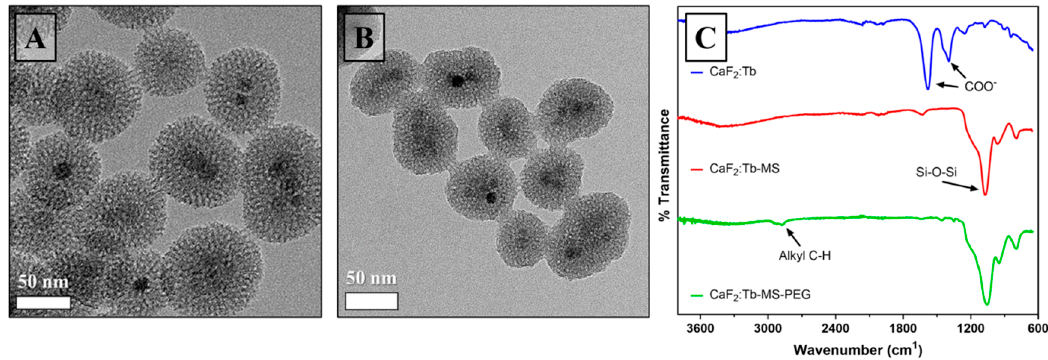
Figure 3. Surface modification of CaF 2 :Tb NPs. TEM images of ( A ) CaF 2 :Tb-MS NPs and ( B ) CaF 2 :Tb-MS-PEG NPs. ( C ) Fourier transform infrared spectroscopy (FT-IR) spectra of as-prepared CaF 2 :Tb NPs (top), CaF 2 :Tb-MS NPs (middle), and CaF 2 :Tb-MS-PEG NPs (bottom).